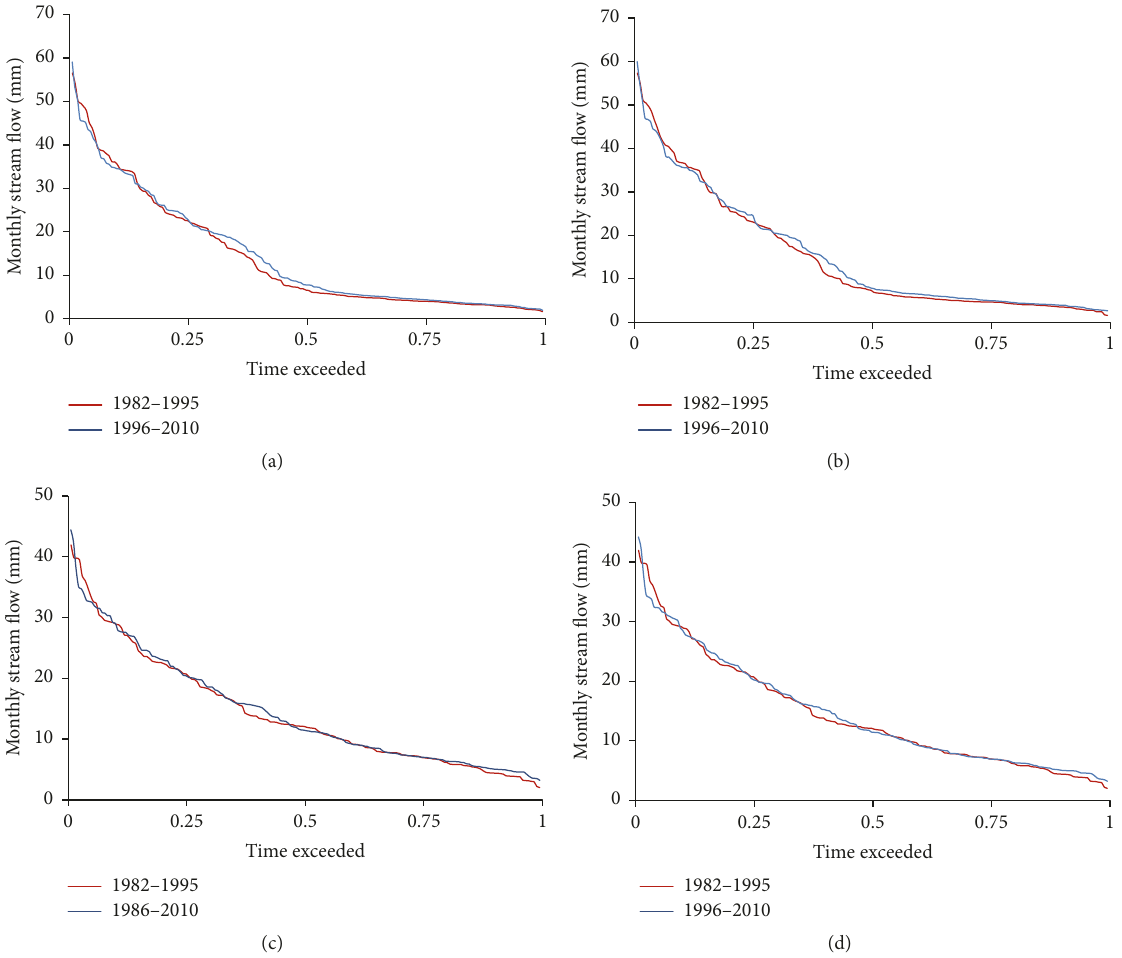
Figure 9: Impacts of climate change on flow duration curve in YLC for (a) LU1980s and (b) LU2000s and in MXC for (c) LU1980s and (d)